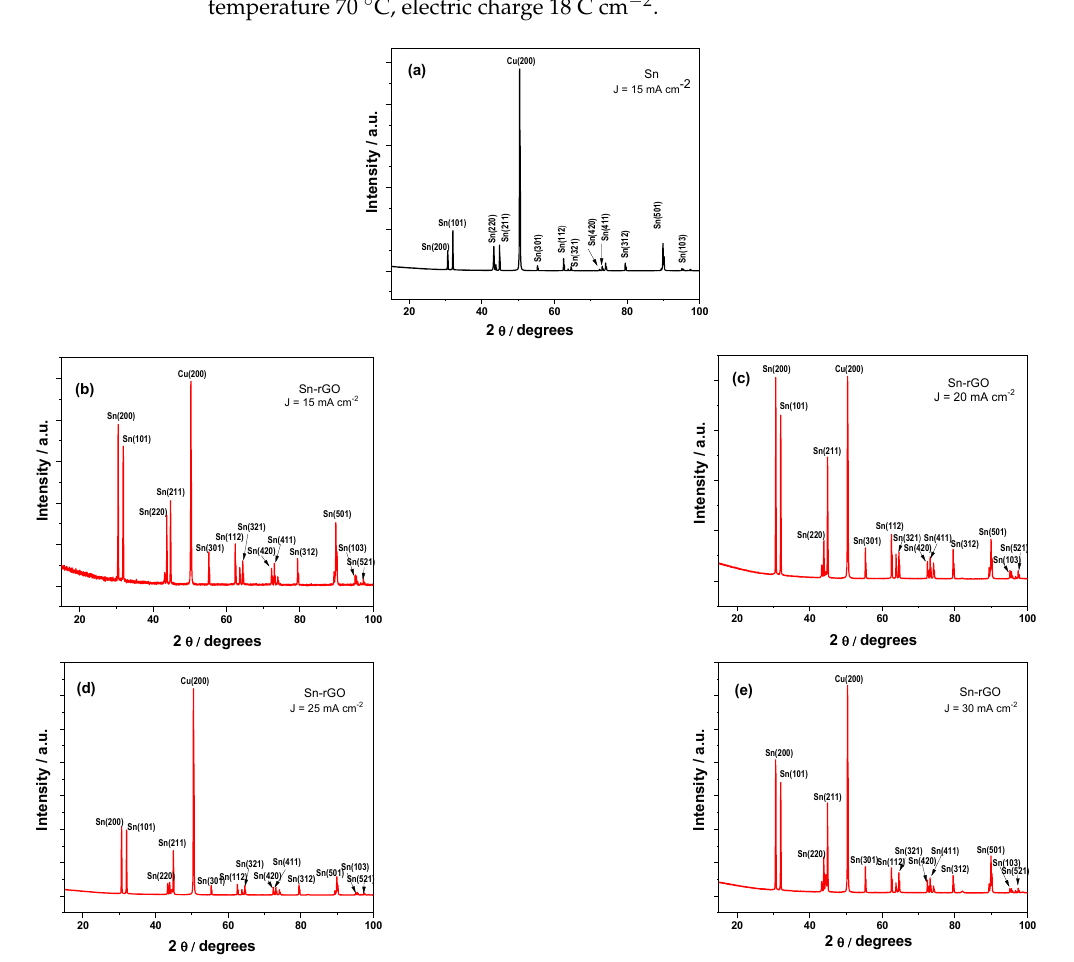
Figure 9. Comparative X-ray patterns of: ( a ) Sn electrodeposited at 15 mA cm − 2 from ILEG + 0.7 M SnCl 2 and ( b–e ) Sn-rGO electrodeposited from ILEG + 0.7 M SnCl 2 + 20 mg L − 1 GO at different current densities: ( b ) 15 mA cm − 2 ; ( c ) 20 mA cm − 2 ; ( d ) 25 mA cm − 2 ; ( e ) 30 mA cm − 2 ; temperature 70 °C.